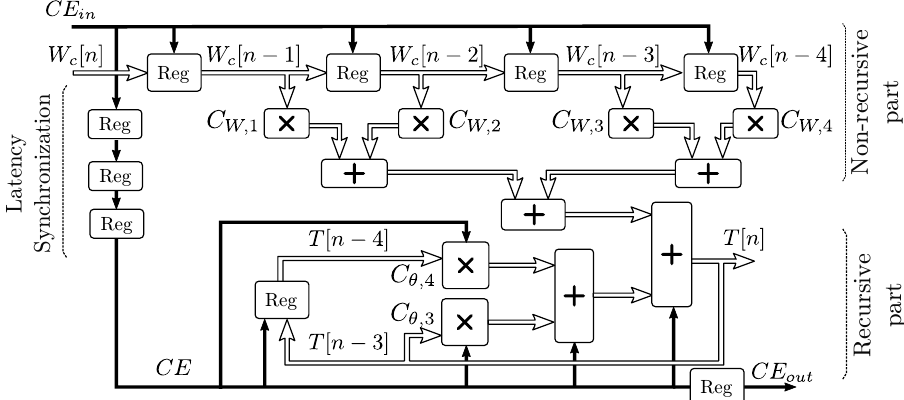
Figure 5. Fully pipelined self-heating model